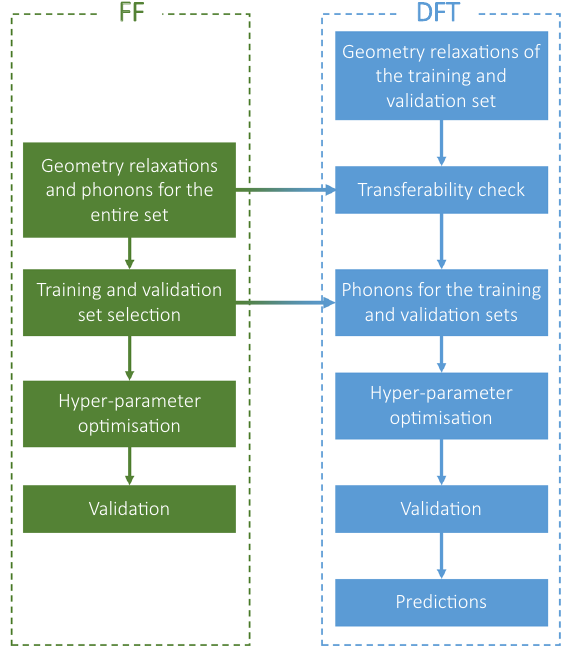
Fig. 3 Flowchart of the developed framework. An optimal and small training set is obtained by training the model on force fi eld data (green boxes) and then used to train the model on DFT data (blue